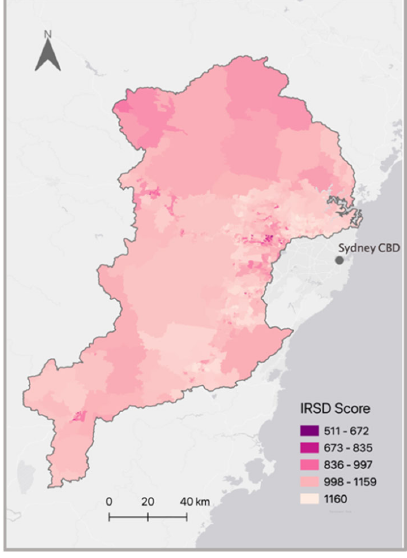
Figure 7. Map depicting Index of Relative Socio ‐ economic Disadvantage (IRSD) data across the Hawkesbury ‐ Nepean Catchment before standardising with Fuzzy membership.